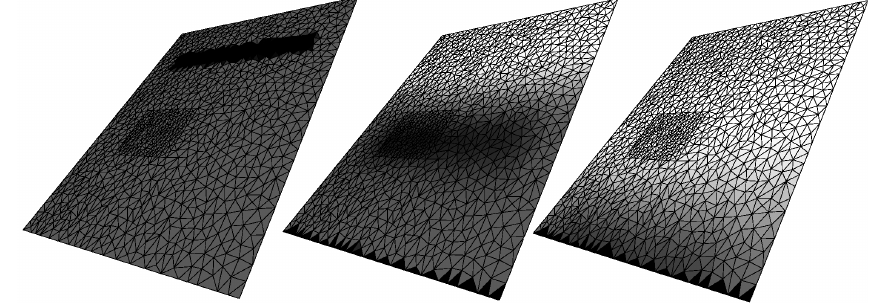
Fig. 4. Water flow on a triangulated irregular mesh describing an inclined plane. The three images show the soil moisture (white = dry, black = wet) at the beginning and after 20 and 40 time steps, respectively.